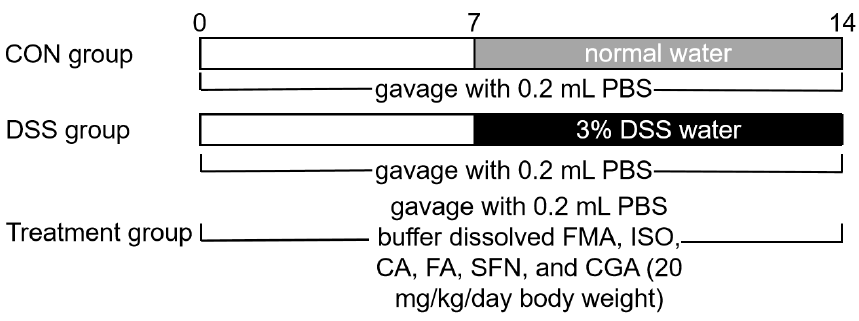
Figure 2. Flow chart of experimental design.